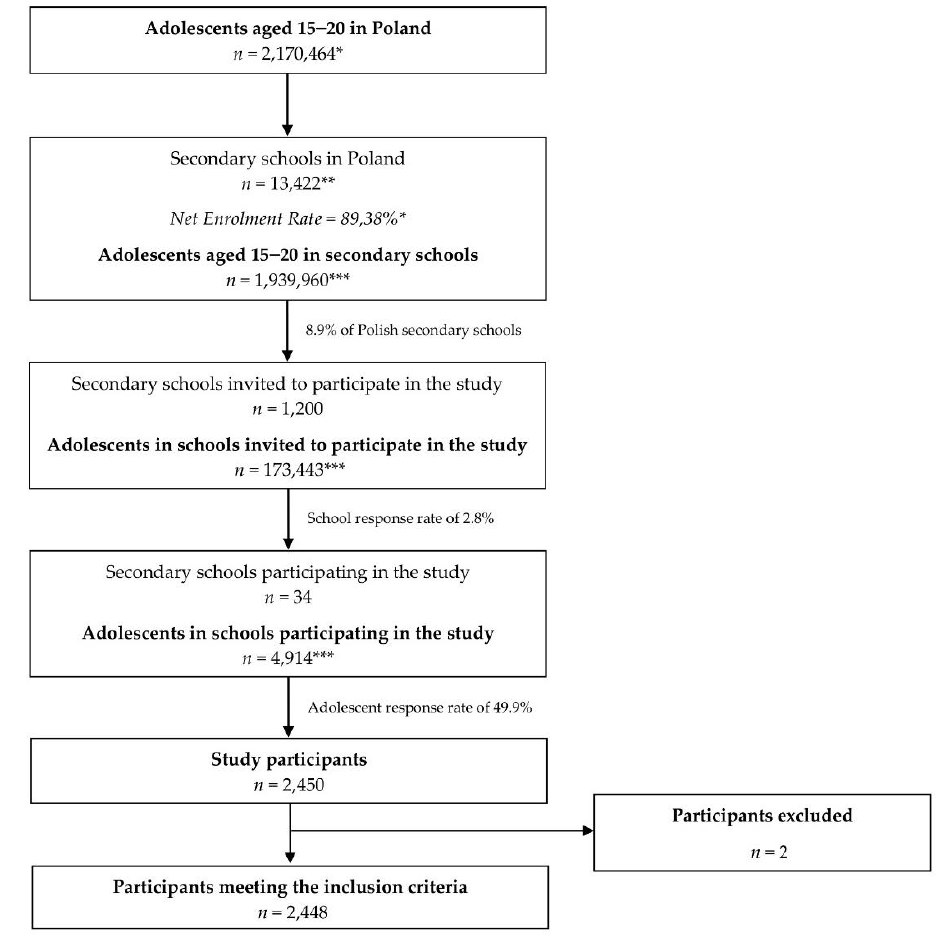
Figure 1. The procedure of secondary school sampling and students including to the Polish Adolescents’ COVID-19 Experience (PLACE-19) Study. * statistics of the Central Statistical Office (CSO) in Poland [23,24];** statistics of the Polish Ministry of National Education [25];*** calculated on the basis of the statistics of CSO.